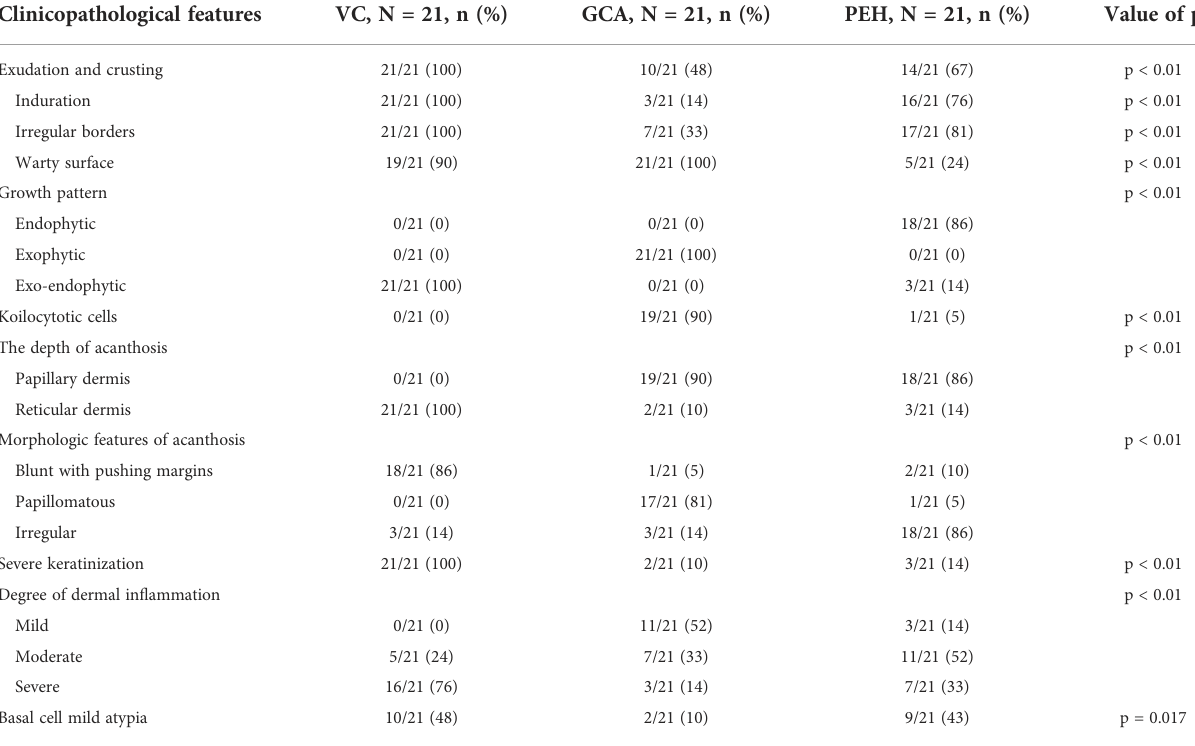
TABLE 3 Clinicopathological features of cutaneous CVC, GCA, and PEH. Clinicopathological